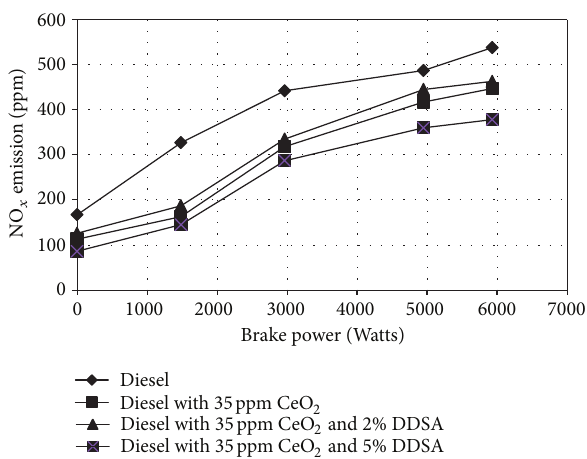
Figure 13: Variation of NO 𝑥 emissions with load for diesel and modified diesel (35ppm of CeO 2 ) for different vol % of surfactant